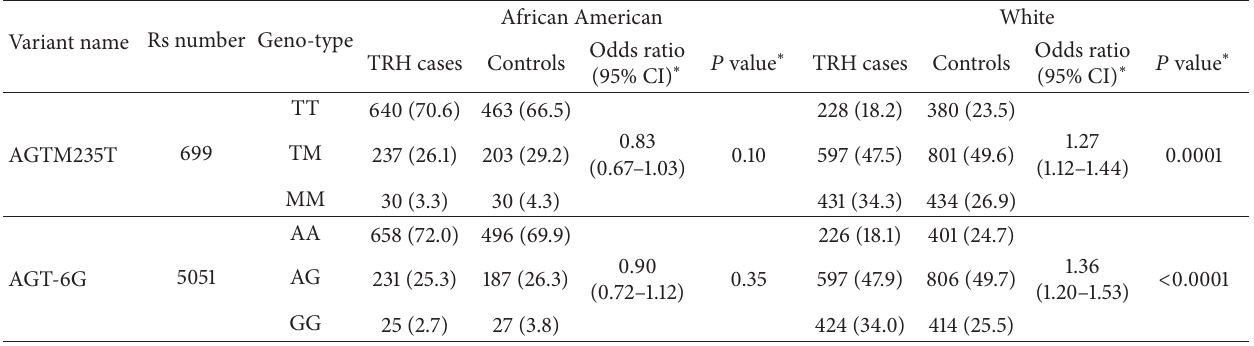
Table 4: Significant gene associations with treatment resistant hypertension.